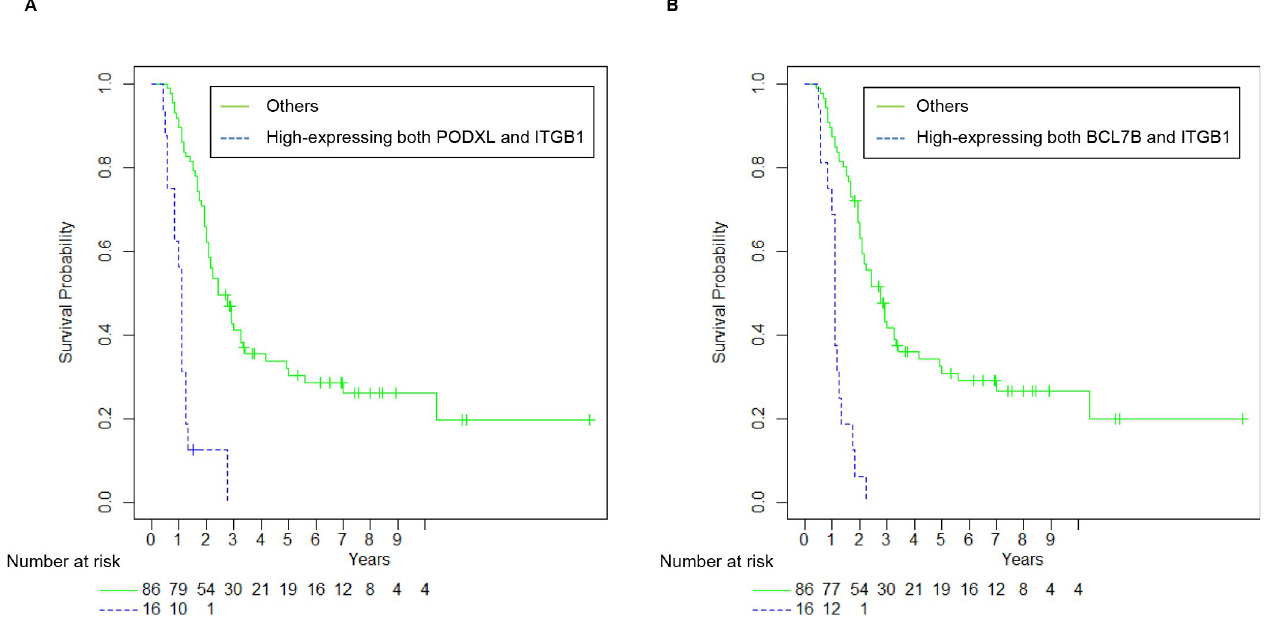
Fig 4. Correlation between high expression of two protein combinations and poor outcomes in all PDAC patients. (A, B) Kaplan-Meier analysis of postoperative survival according to (A) the combination of PODXL with ITGB1 and (B) the combination of BCL7B with ITGB1 in all PDAC patients.